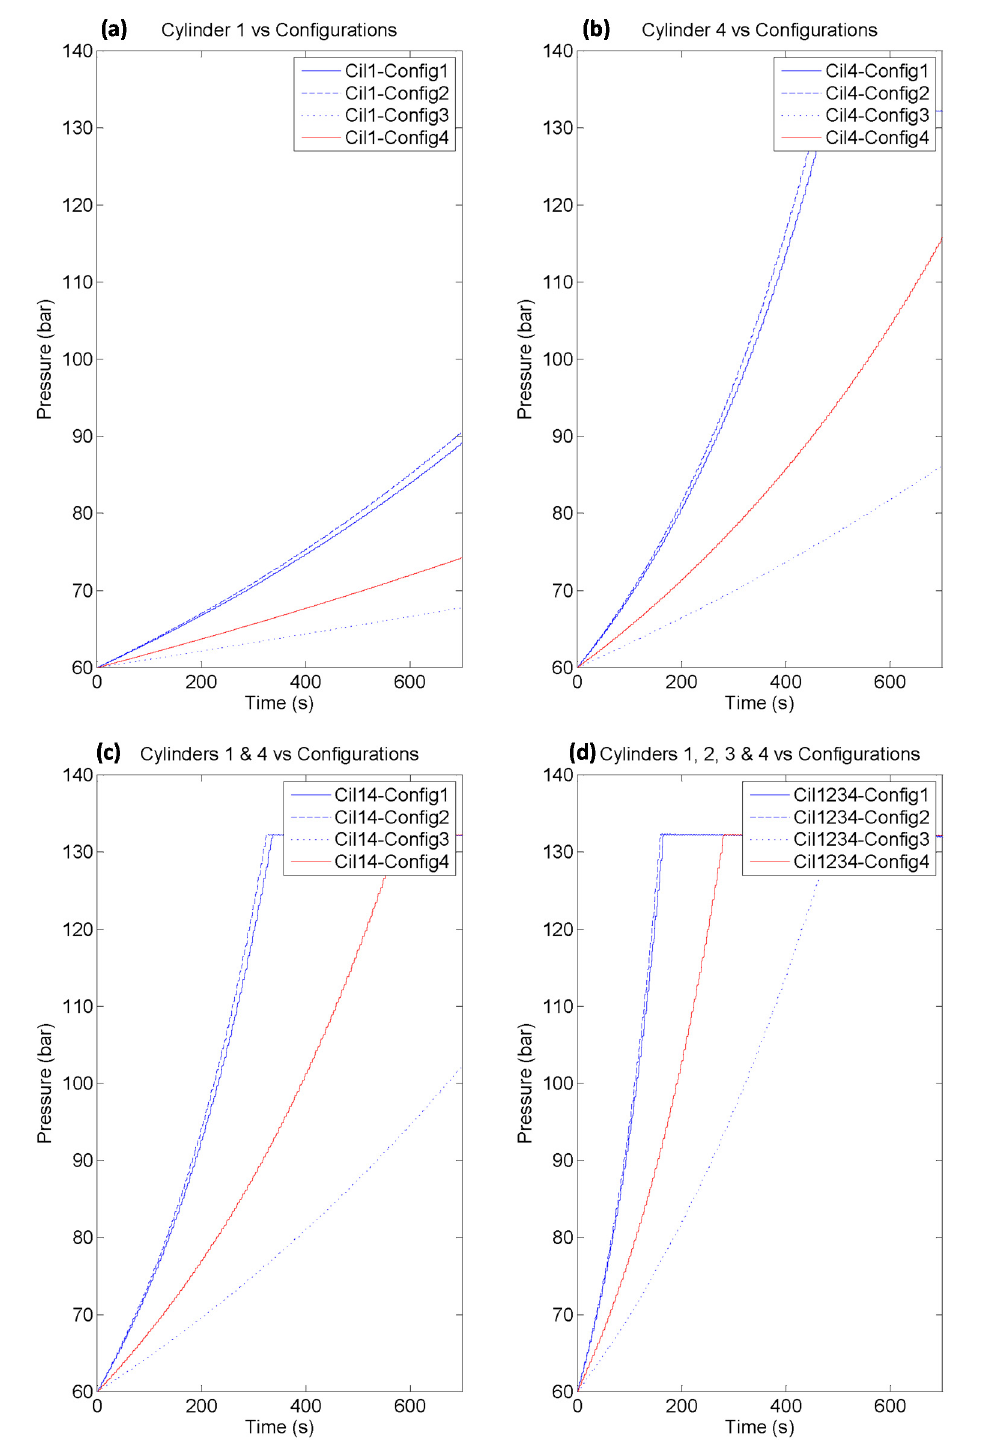
Figure 13. HP accumulator pressure evolution related to geometrical configuration, using a specific combination of active hydraulic cylinders. ( a ) Cylinder 1; ( b ) Cylinder 4; ( c ) Cylinders 1 and 4; ( d ) Cylinders 1, 2, 3 and